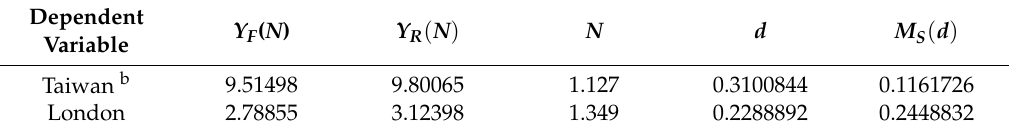
Table 3. Key di ff erences in findings between the Taiwan and London security